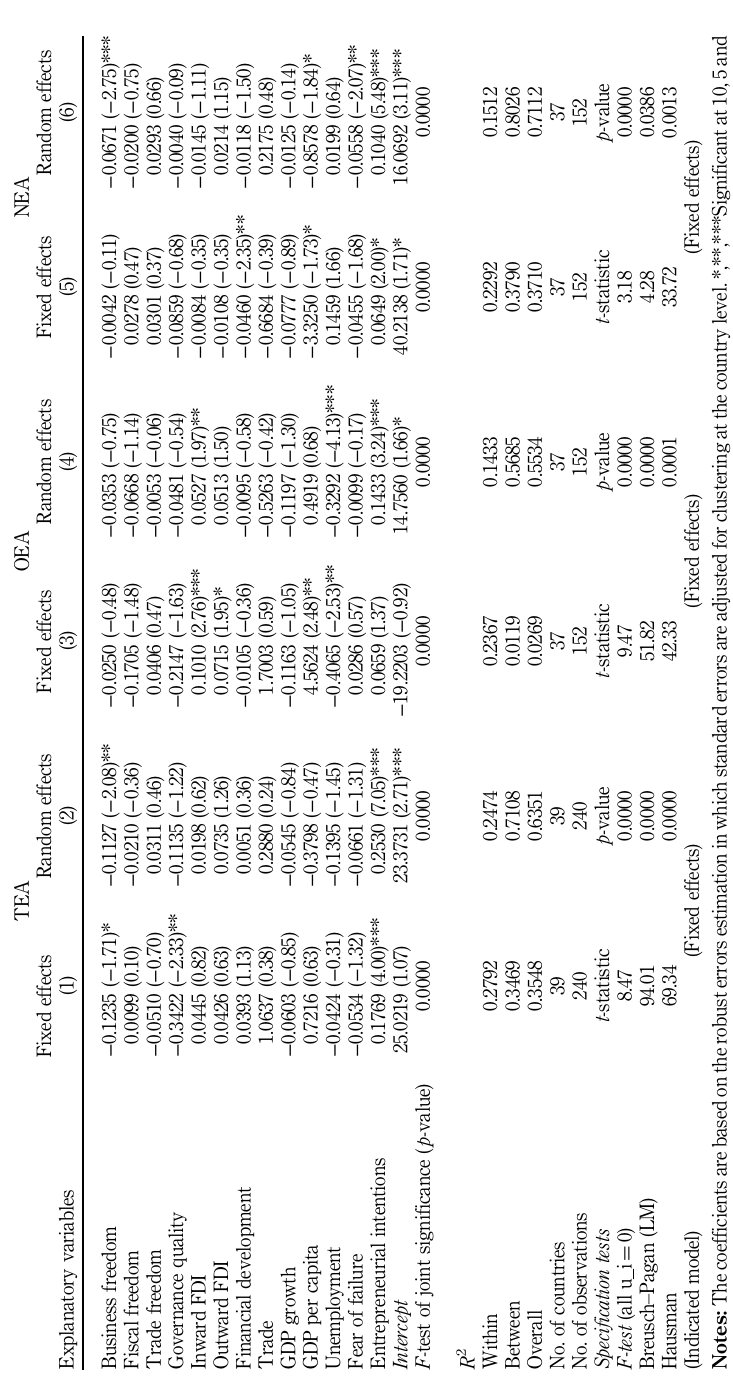
Table IV. Institutions, FDI